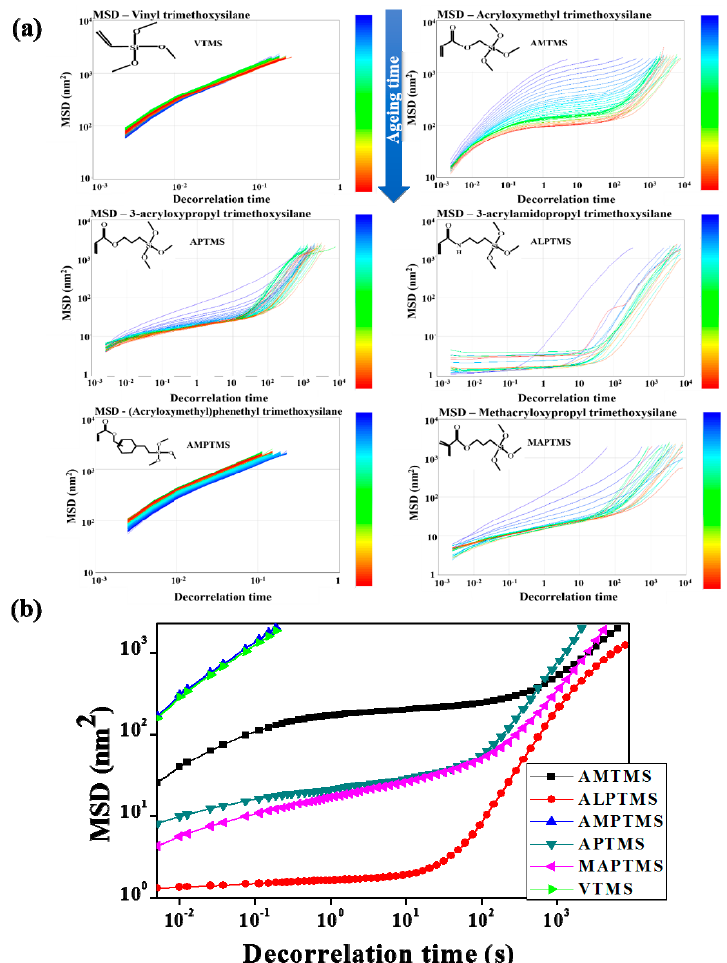
Figure 6. MSD-decorrelation time curves of the SCA-coated Al 2 O 3 /High-temp composite solutions with different organofunctional groups: ( a ) MSD-decorrelation time curves during 48 h and ( b ) MSD-decorrelation time curves at 12 h.